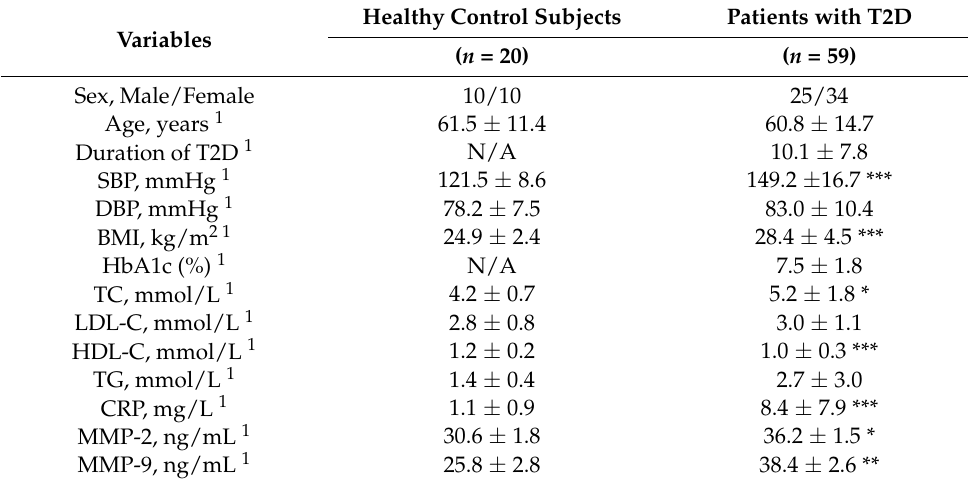
Table 1. Clinical characteristics of the